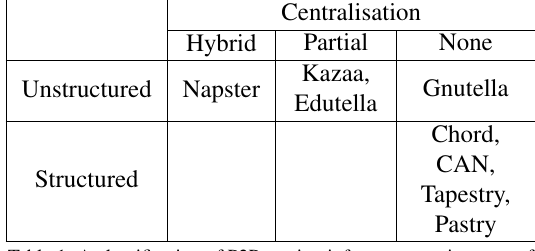
Table 1. A classification of P2P routing infrastructures in terms of network